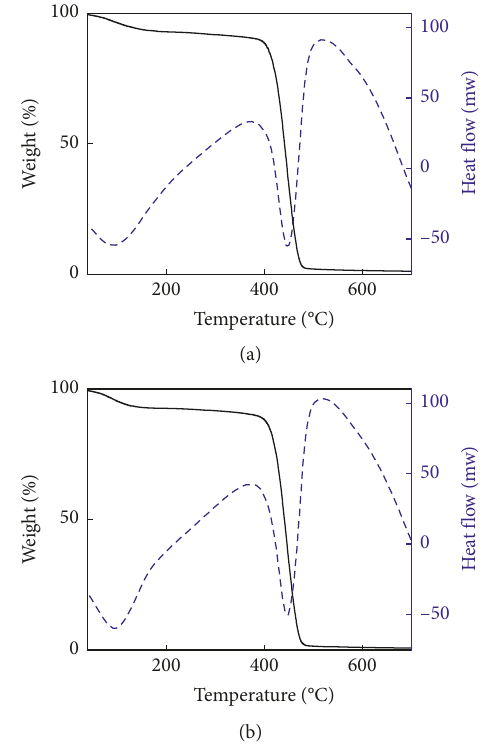
Figure 13: DSC-TAG analyses of Eu(BA)(TTA) Eu(BA)(TTA) 2 Phen/PVP